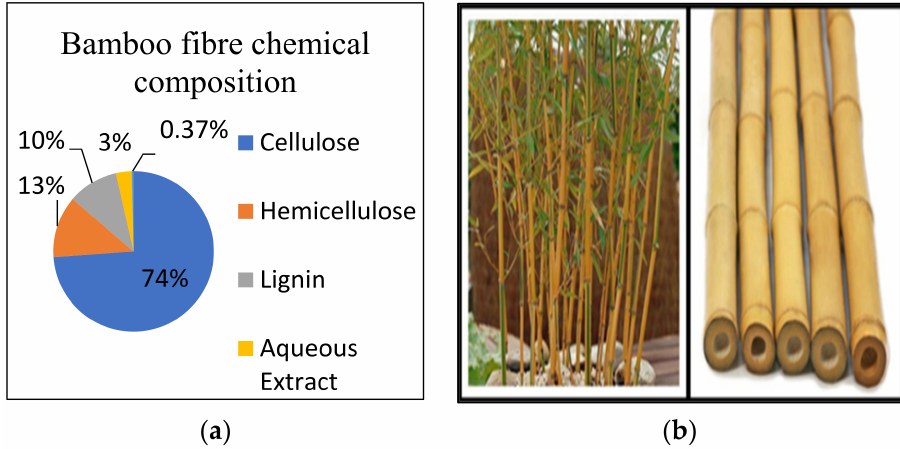
Figure 20. ( a ) Bamboo fibre chemical composition ( b ) bamboo plant and